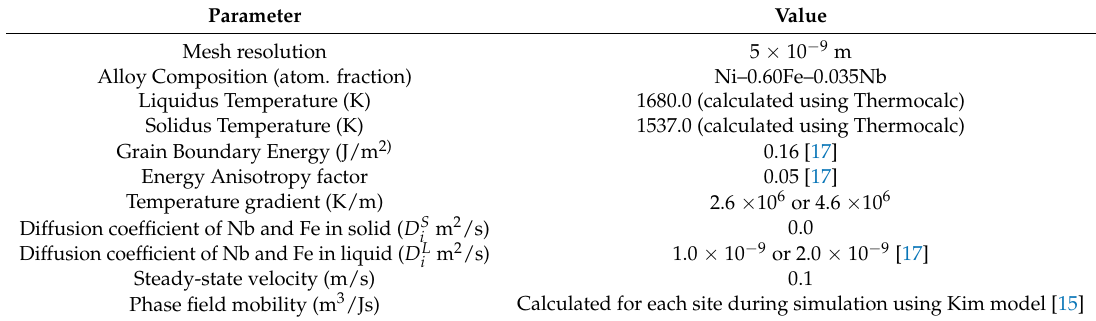
Table 3. Parameters used in the phase field simulations.